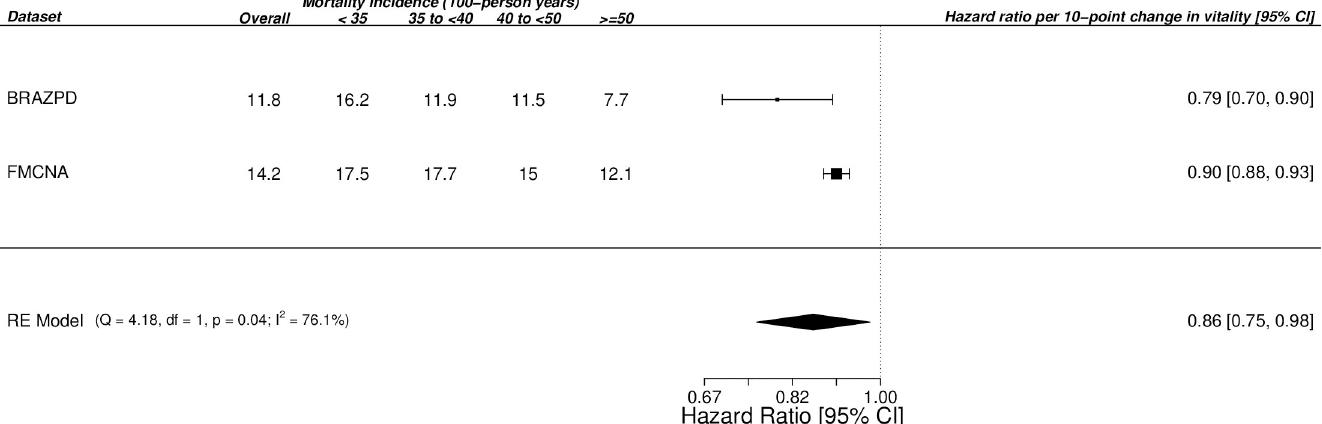
Fig 4. Forest Plot for the random-effects meta-analysis of hazard ratios for each 10-unit increase in vitality scores. CI: Confidence Interval.